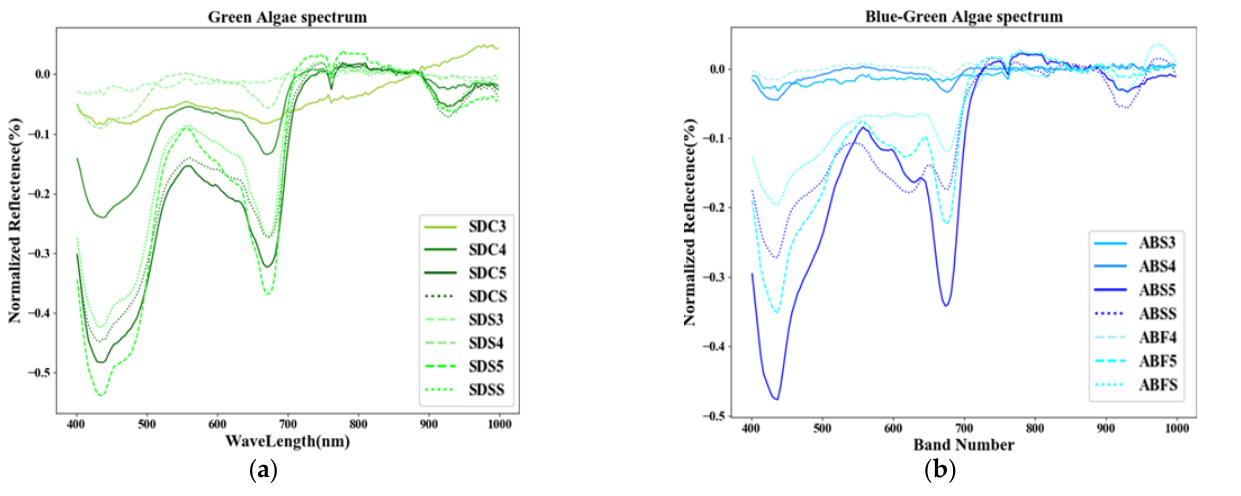
Figure 8. Graph of algae spectrum from 400 to 1000 nm. (( a ) green algae spectrum—this graph shows the absorption spectrum of the green algae sample used in this study, ranging from 400 to 1000 nm; ( b ) blue-green algae spectrum—this graph depicts the absorption spectrum of the blue-green algae sample used in this study, ranging from 400 to 1000 nm).